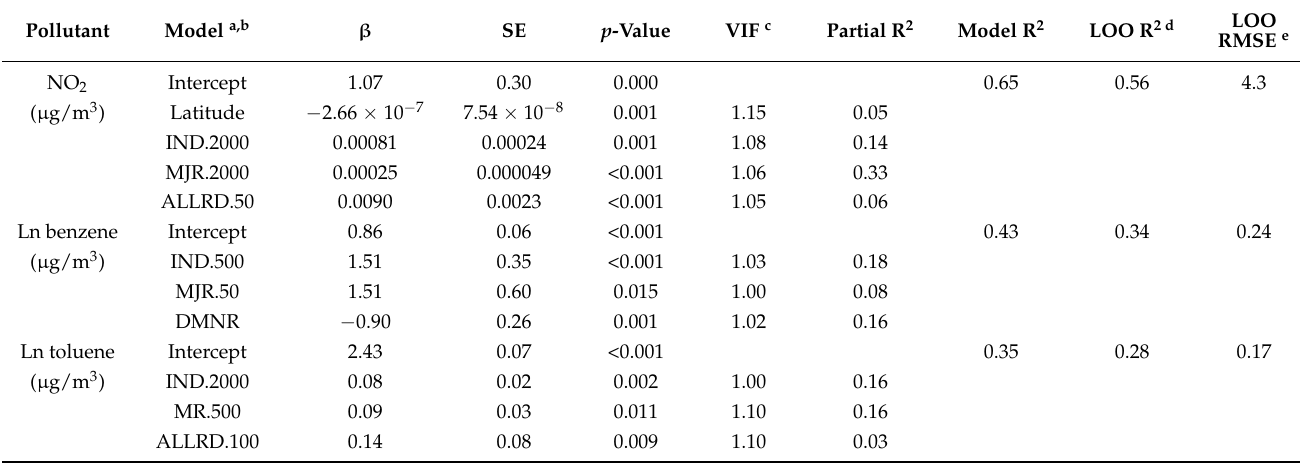
Table 5. Final land-use regression models for NO 2 , benzene, toluene, and